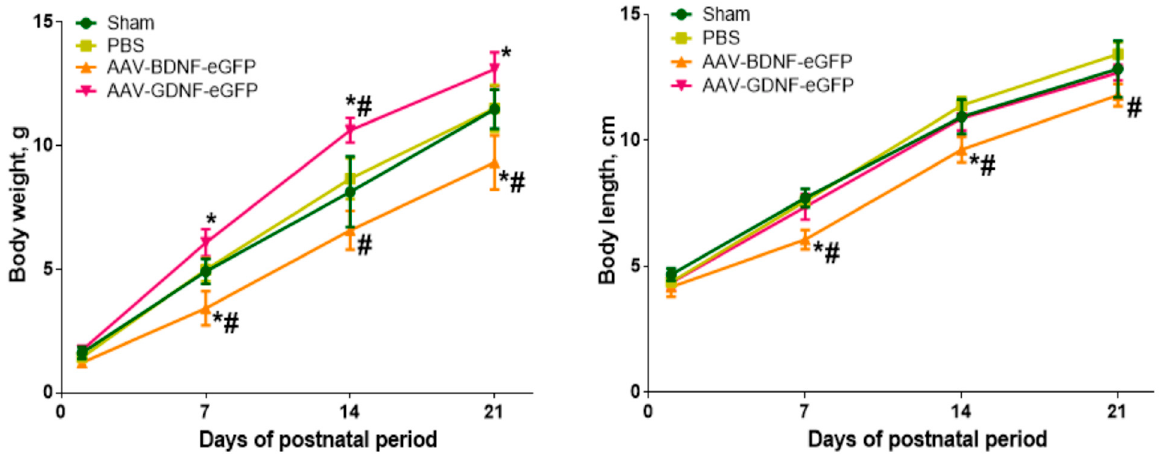
Figure 2. Body mass and body length values of newborn mice during three weeks of the postnatal period. *-vs. “Sham”, #-vs. “PBS”, p < 0.05, one-way ANOVA with multiple comparison test.